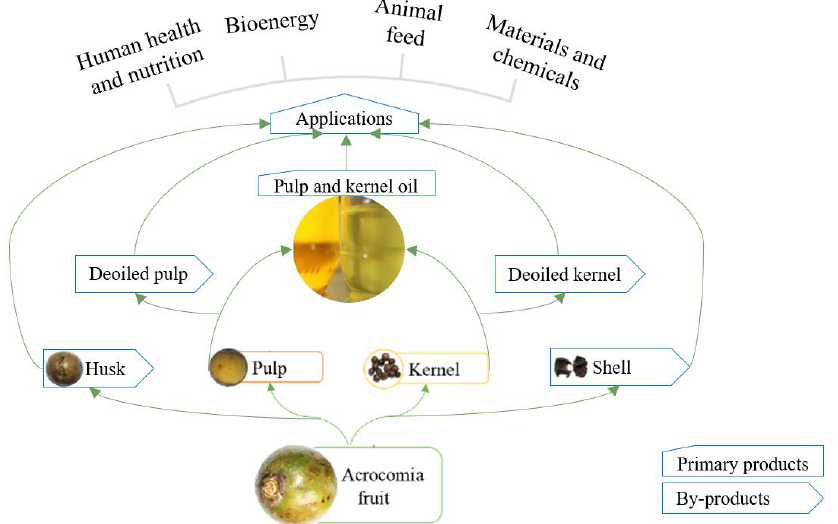
Figure 1. Integral use concept for acrocomia fruits, including oils (primary products), by-products, and targeted sectors. Fruit-to-product pathways (green arrows) vary, for instance, in some regions the primary use of acrocomia pulp is the manufacture of flour, soft drinks, sweets, jellies, and ice creams [6,7,11,21,22]. Figure adapted from [4,7,10,15 – 21,23].